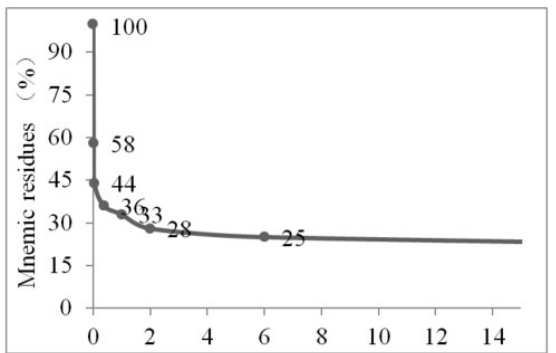
Figure 2. The Ebbinghaus forgetting curve.